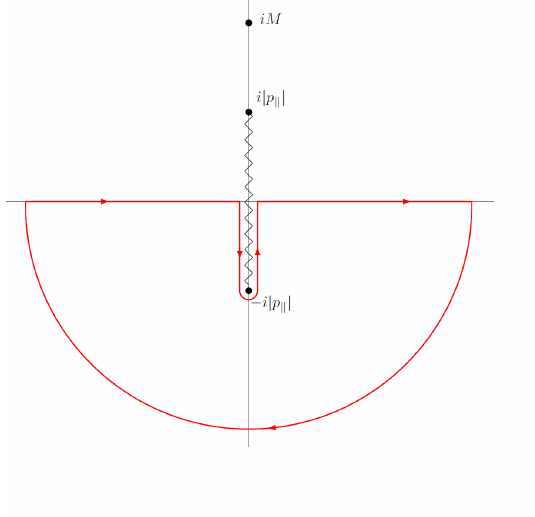
Figure 1: Integration countour for M > | p (cid:107) | closed in the lower plane with a branch cut between ( − i | p (cid:107) | , + i | p (cid:107) | ) and a simple pole at iM . In the case M < | p (cid:107) | we take the branch cuts between infinity and ± i | p (cid:107) | to move the pole away from them (this will not change the resulting